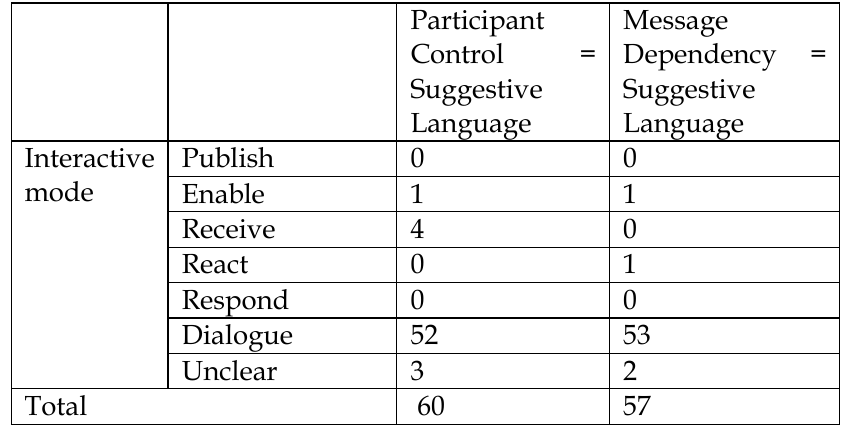
Table 7: Suggestive Language Frequencies by Mode of Interaction